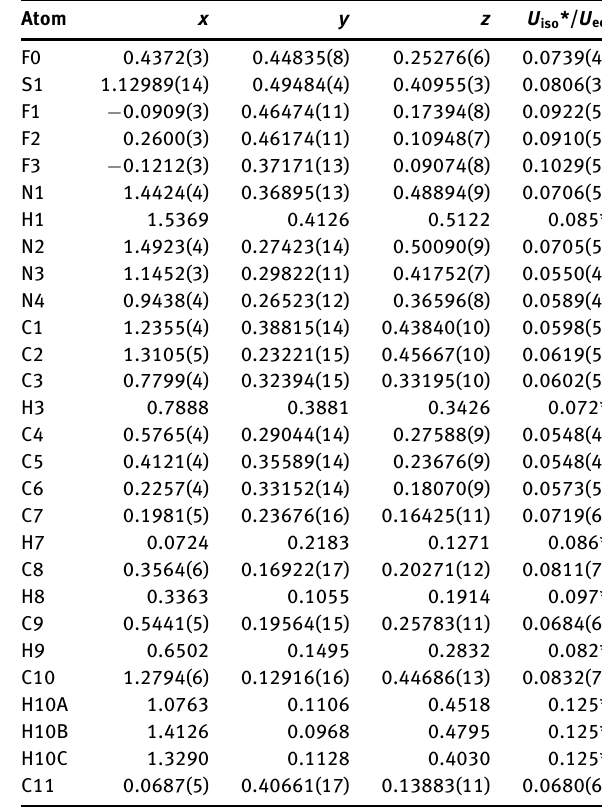
Table 2: Fractional atomic coordinates and isotropic or equivalent isotropic displacement parameters (Å 2